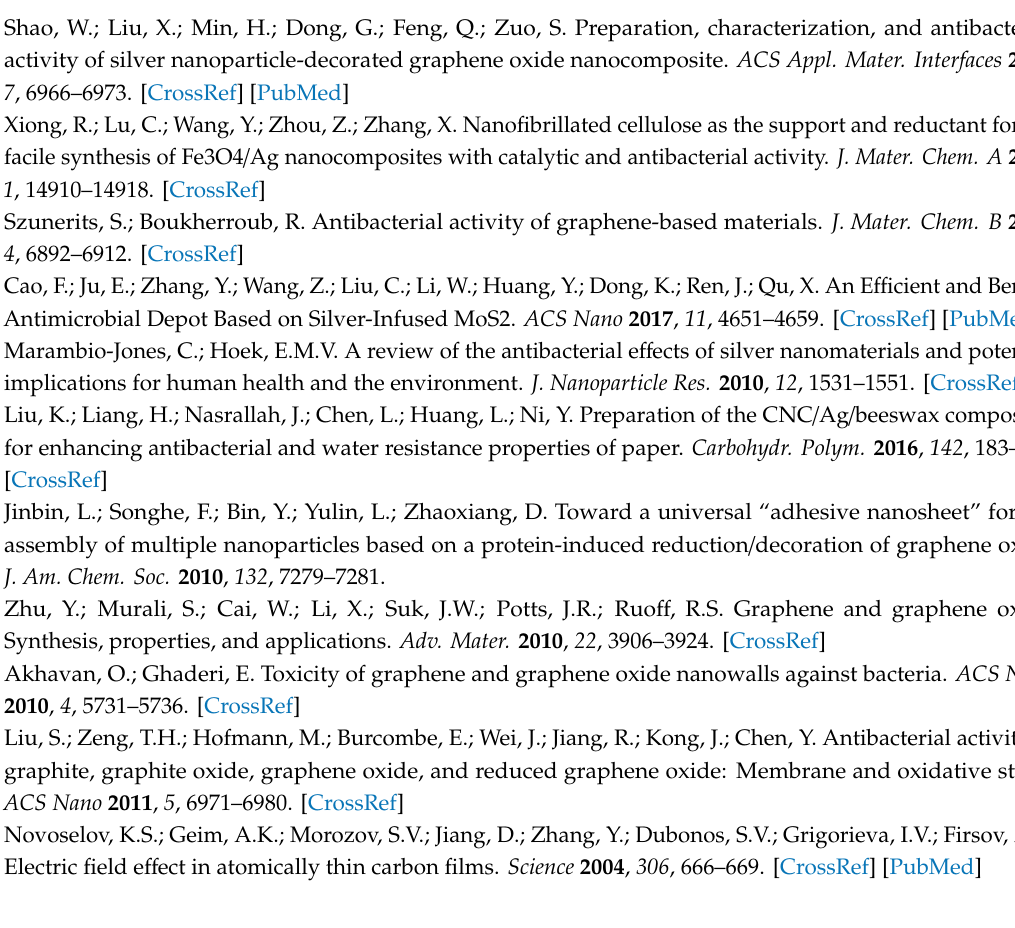
Figure S1: The TEM image of